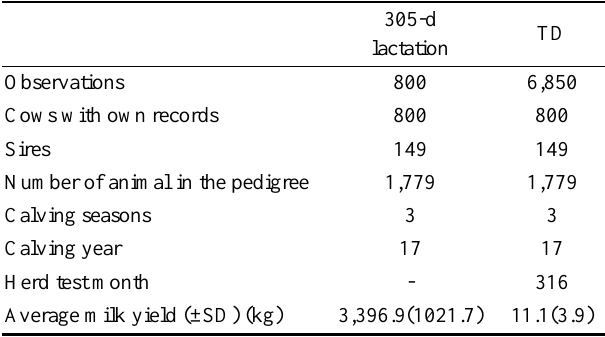
Table 1. Description of statistics of the 305-d lactation and